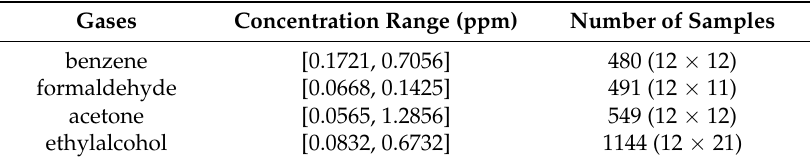
Table 3. Concentration of the target gases.